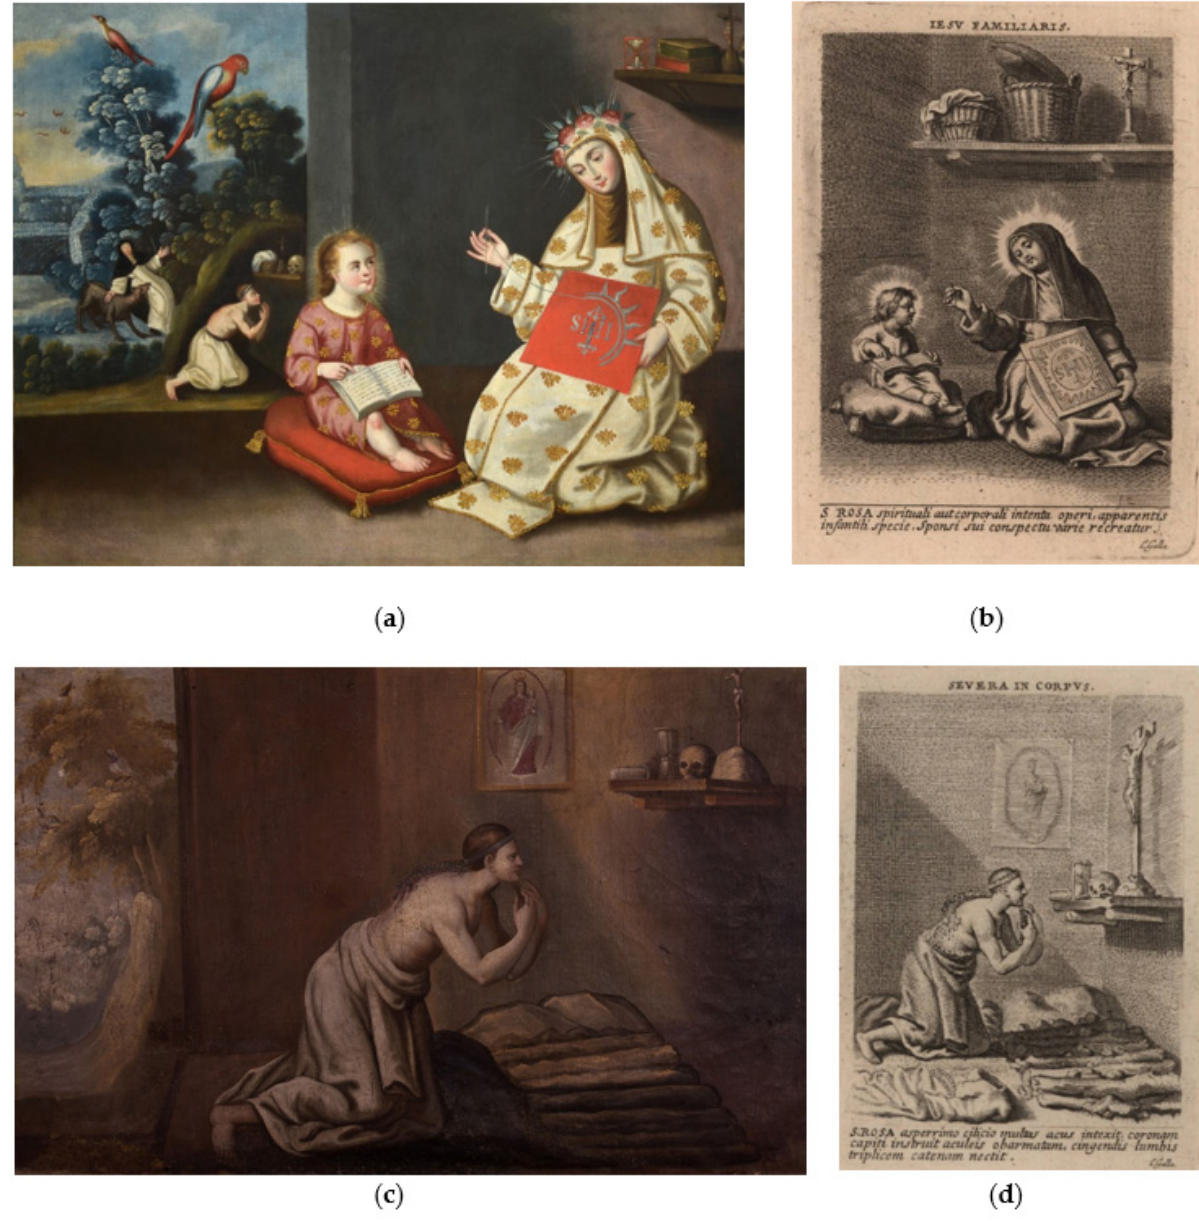
Figure 10. ( a ) Unidentified artist, Saint Rose sewing , 18th century, oil on canvas, Carl and Marilynn Thoma collection. Credit line: Thoma Foundation. ( b ) Cornelis Galle II (1615–1678), Iesu familiaris, c. 1672, engraving, in Series on the Life of Saint